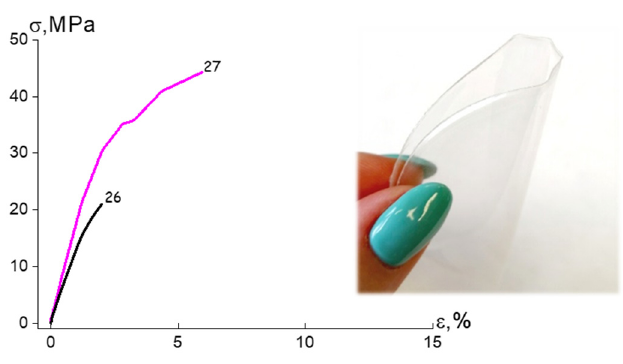
Figure 16. Stretching curves of polymers 26 – 27 .